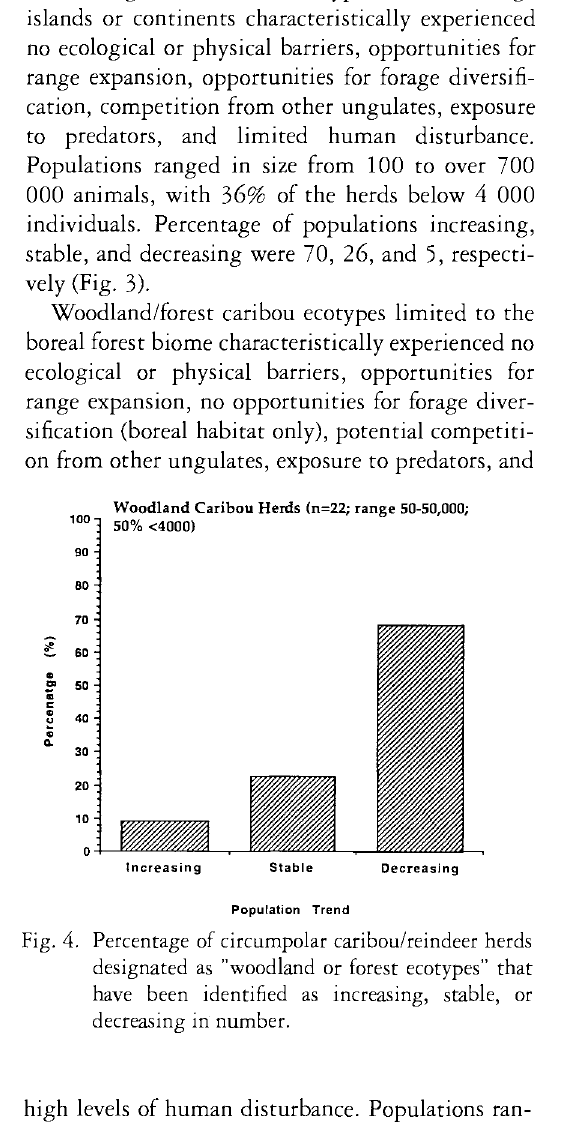
Fig. 4. Percentage of circumpolar caribou/reindeer herds designated as "woodland or forest ecotypes" that have been identified as increasing, stable, or decreasing in